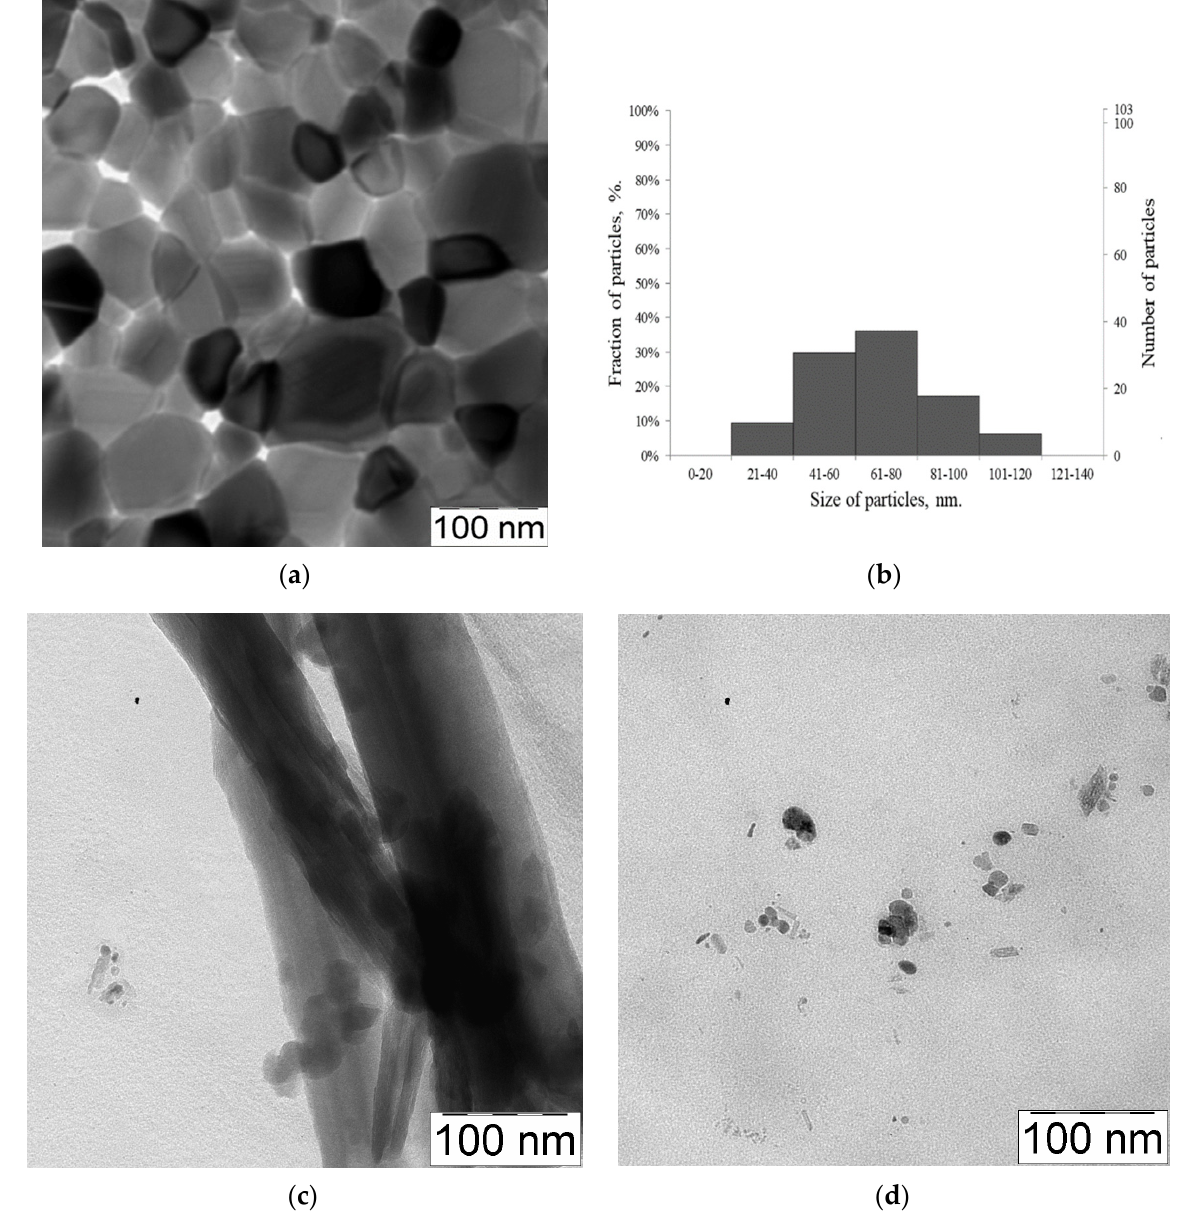
Figure 3. TEM images of investigated samples: ( a ) CoFe 2 O 4 ; ( b ) particle size distribution of CoFe 2 O 4 ; ( c ) Fe-smectite; ( d ) nanocomposite Bt-20F.